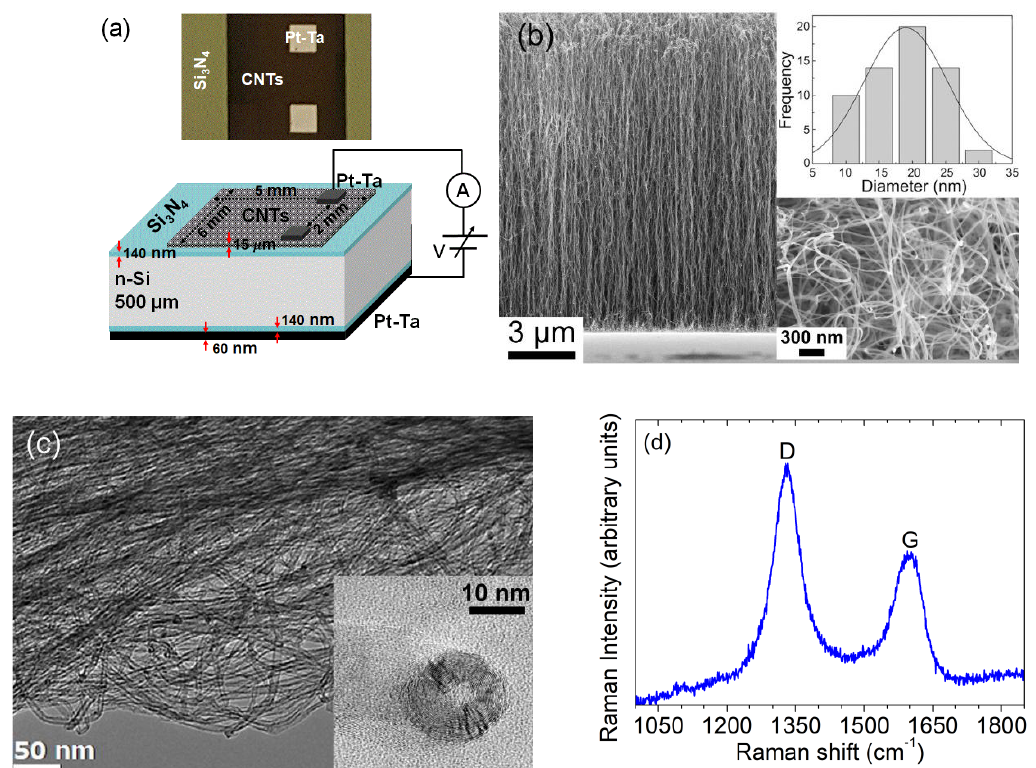
Figure 1. ( a ) Top image of the device after the multi-walled carbon nanotube (MWCNT) growth (black area) and layout of the device with the setup used for the electrical characterization of the Pt - Ta_CNT/Si 3 N 4 /Si/Si 3 N 4 /Pt - Ta heterostructure. ( b ) Scanning electron microscope (SEM) image of the MWCNT film. The insets show the distribution of the outer diameter (top inset) and the top view of the film (bottom inset). ( c ) Transmission electron microscope and high-resolution transmission electron microscope (HRTEM) (bottom inset) images of the MWCNTs. ( d ) Raman spectrum of the MWCNT film.